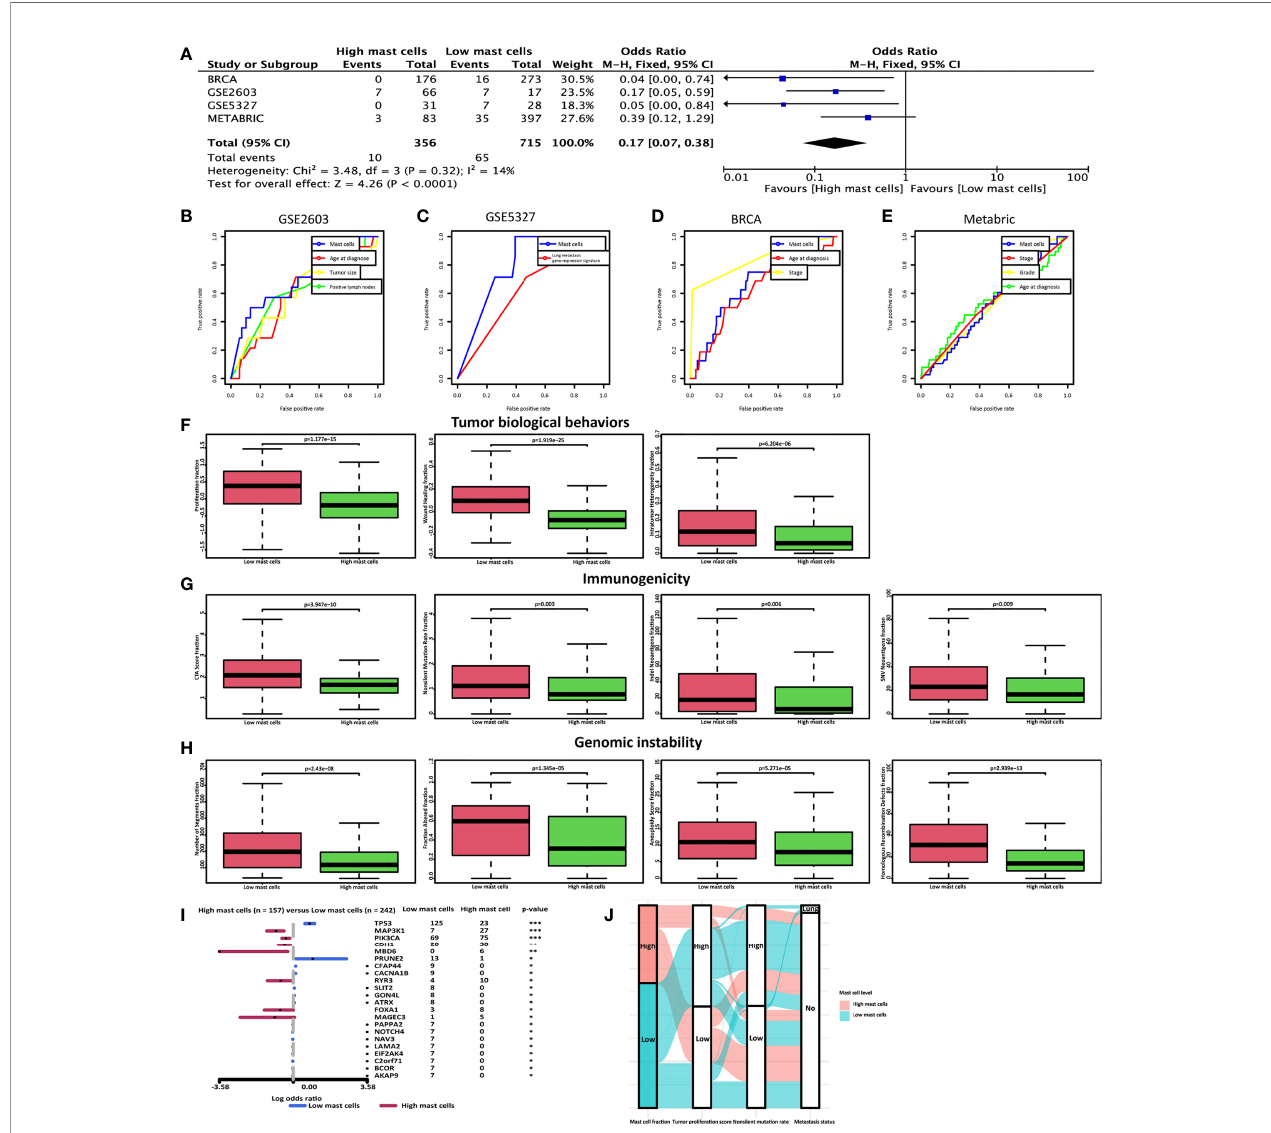
FIGURE 5 | Low mast cell fraction could be an indicator of lung metastasis in breast cancer patients. (A) Meta-analysis was performed to calculate the pooled OR of mast cell fraction. ROC curves of mast cell fraction, age at diagnosis, tumor size, positive lymph nodes number, grade, TNM staging system, and signature reported by another study (29) in predicting lung metastasis in (B) the GSE2603 cohort, (C) the GSE5327 cohort, (D) the TCGA cohort, and (E) the METABRIC cohort. The AUC of the mast cell fraction for lung metastasis risk prediction was 0.682 in the GSE2603 cohort, 0.798 in the GSE5327 cohort, 0.708 in the TCGA cohort, and 0.521 in the METABRIC cohort. Distributions of (F) proliferation score, wound healing score, and intratumor heterogeneity (G) CTA score, mutation burden, and neoantigens (H) the number of segments, fraction altered, aneuploidy score, and HRD score with respect to mast cell-based subtypes. (I) Forest plot with x-axis as log10 converted odds ratio and differentially mutated genes between the high- and the low-mast cell groups on the y-axis. (J) A Sankey plot was used to reveal the correlations between mast cell fraction, tumor proliferation score, non-silent mutation rate, and lung metastasis status. BRCA, breast invasive carcinoma; METABRIC, molecular taxonomy of breast cancer international consortium; TCGA, the cancer genome atlas; OR, odds ratio; ROC, receiver operating characteristic; CTA, cancer testis antigens; HRD, homologous recombination defects; Indel, insertions and deletions; SNV, single-nucleotide variant; AUC, area under the receiver operating characteristics curve; *: p < 0.05; **: p < 0.01; ***: p <